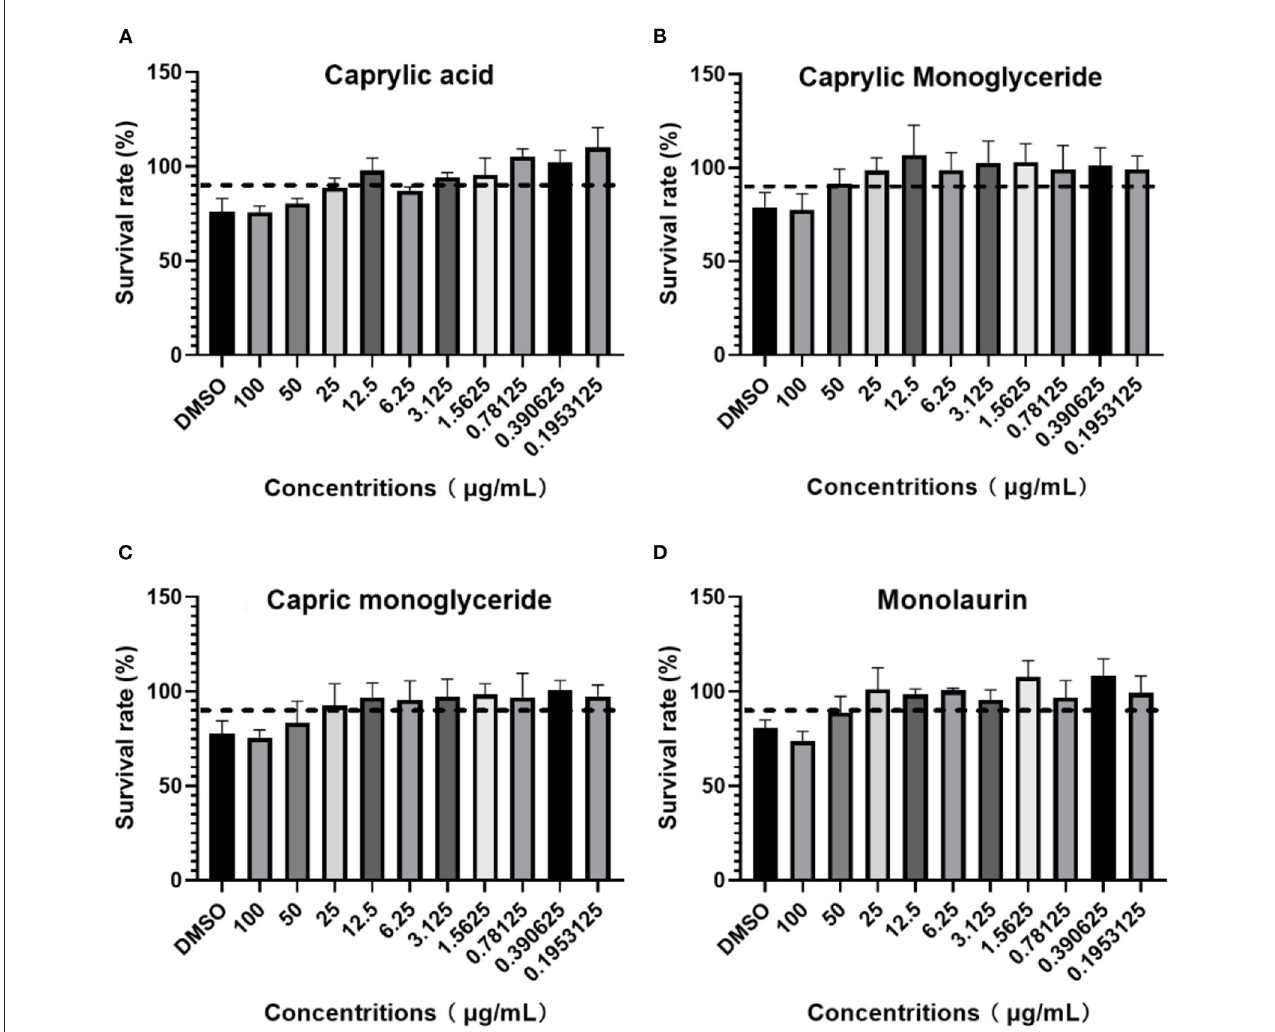
FIGURE1 BHK-21 cell survival rate in: (A) Caprylic acid; (B) Caprylic monoglyceride; (C) Carpric monoglyceride; (D)